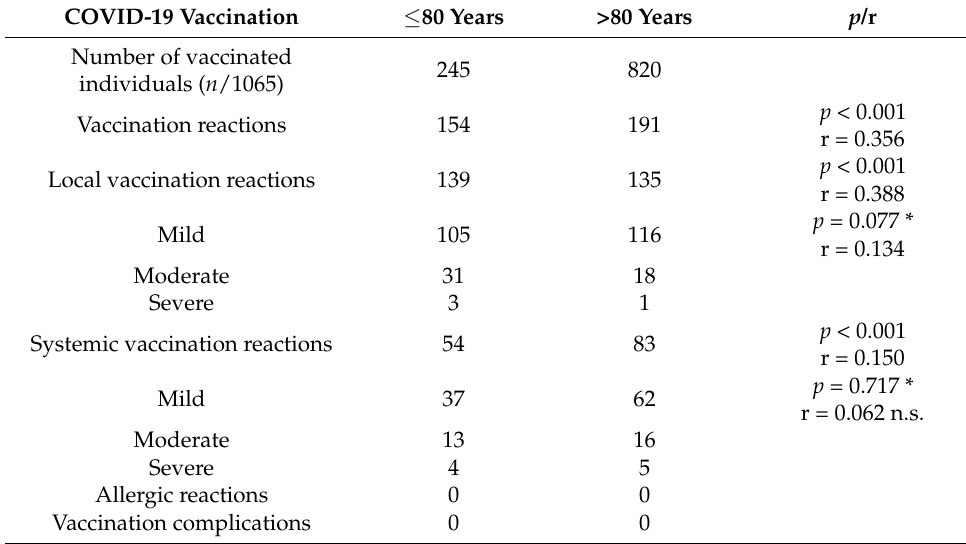
Table 2. Age-graded vaccination reactions ( ≤ 80-year-olds versus >80-year-olds).